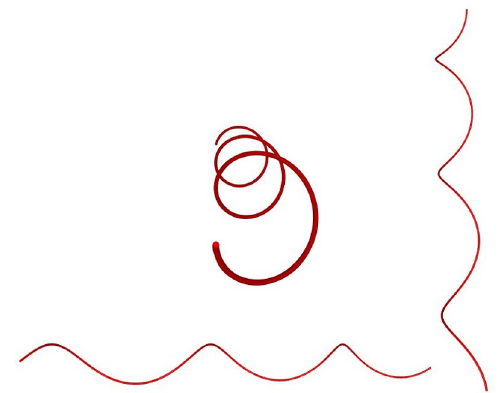
Figure 5. The helical structure of fibres in different views.